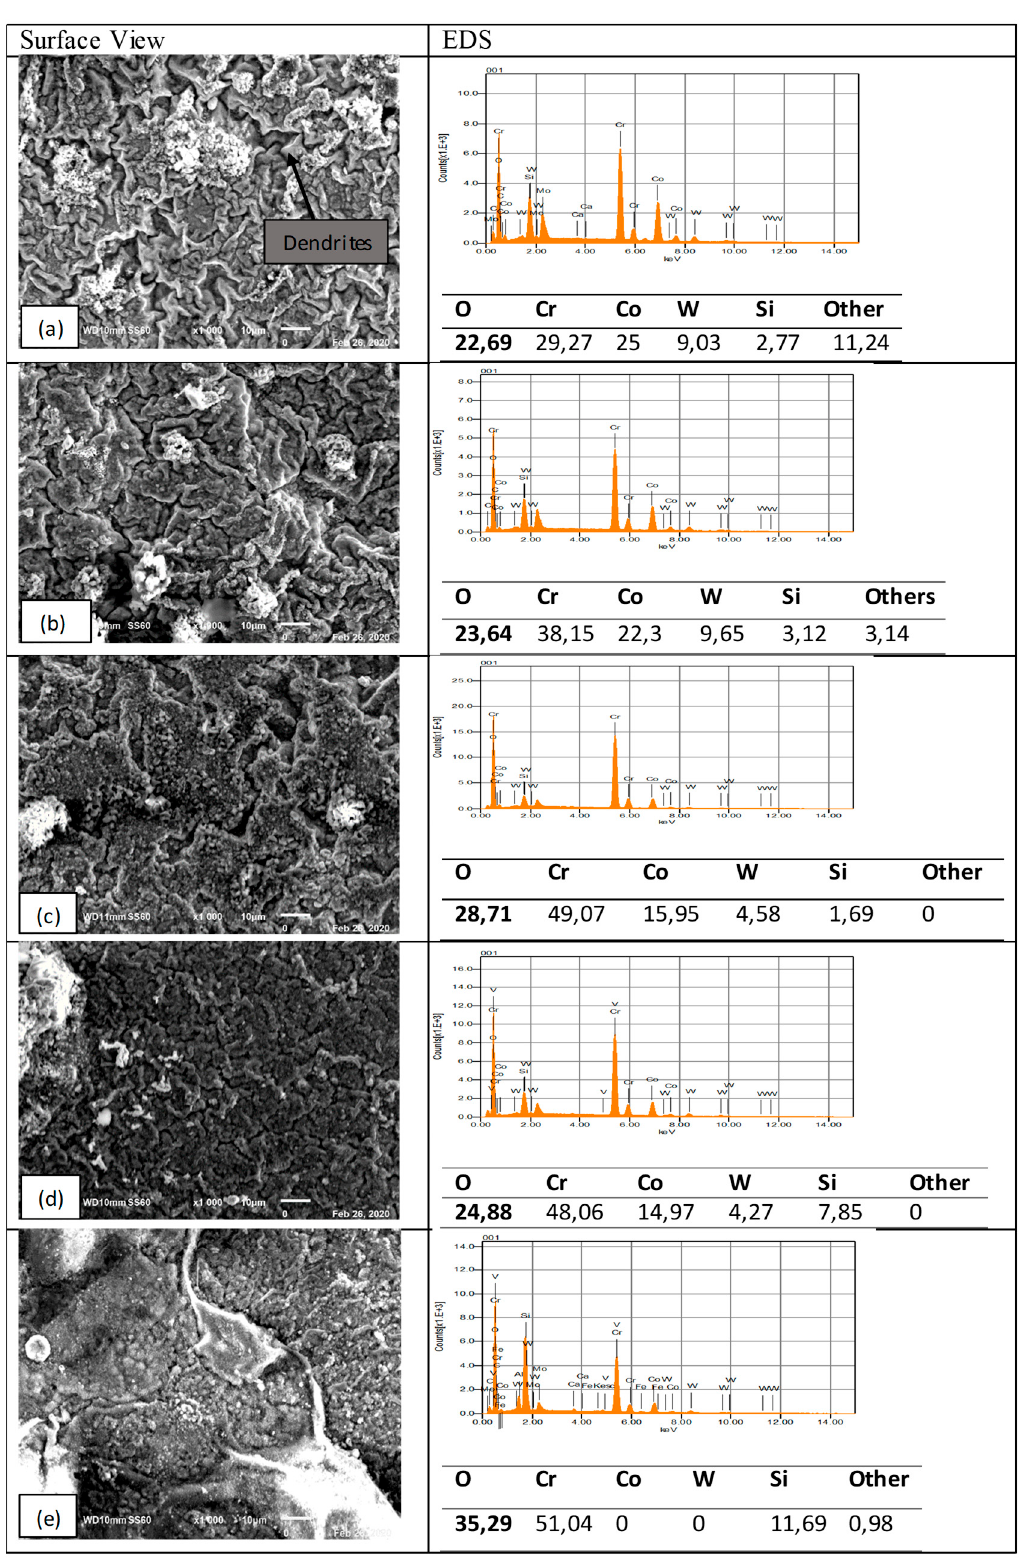
Figure A1. T-800/WC surface view and EDS at ( a ) 24 h, ( b ) 48 h, ( c ) 72 h, ( d ) 96 h and ( e ) 120 h.